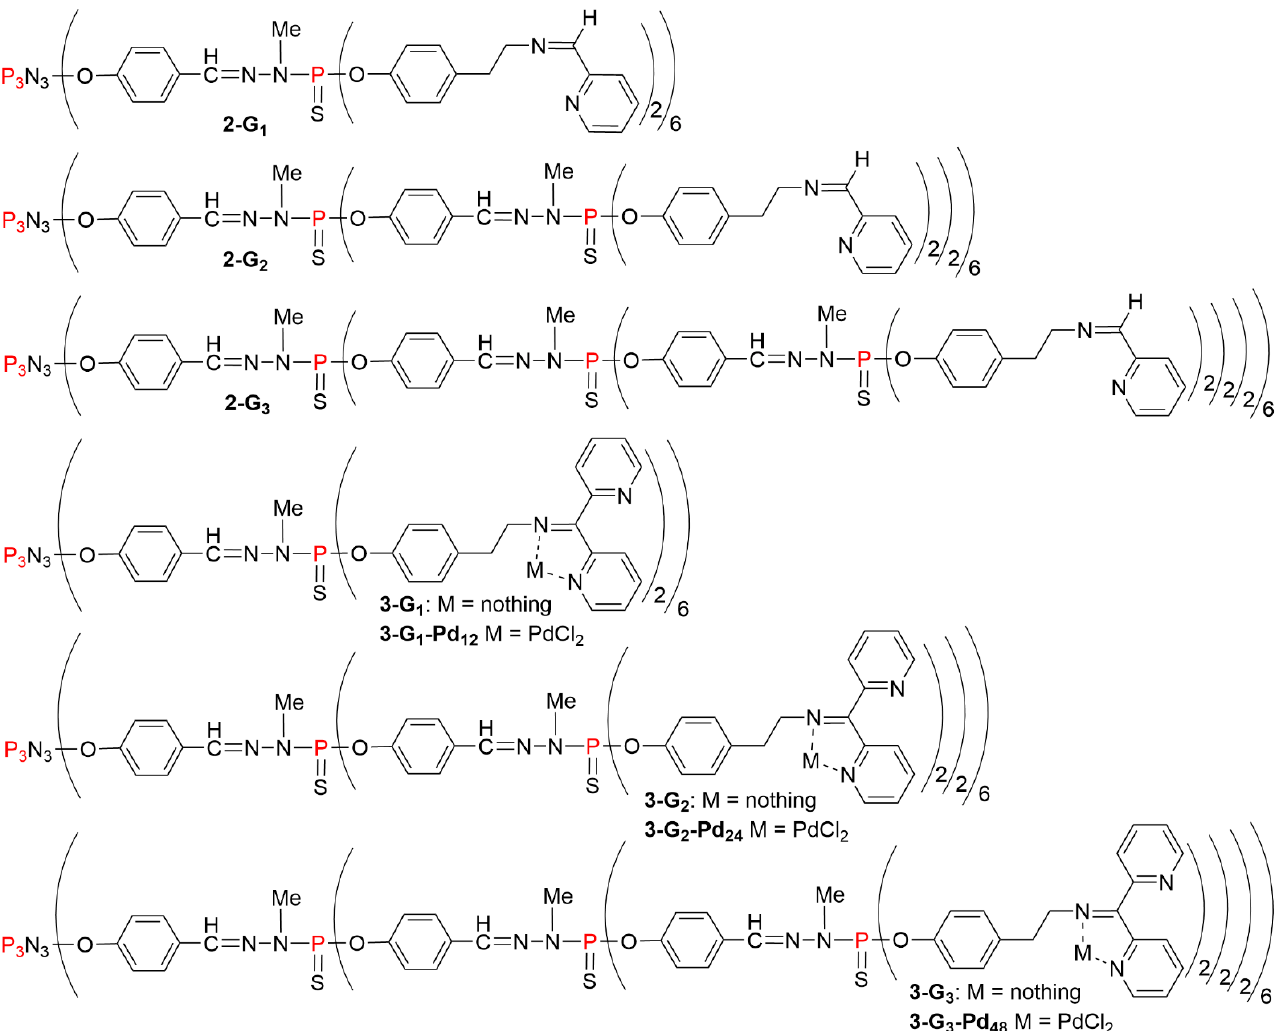
Figure 9. Phosphorhydrazone dendrimers from generations 1 to 3, functionalized with ligands 2 and 3 , affording dendrimers 2-Gn and 3-Gn respectively. Structure of the palladium complexes the 3-Gn family, namely 3-Gn-Pdx ( n = 1–3, x = 12, 24, 48).